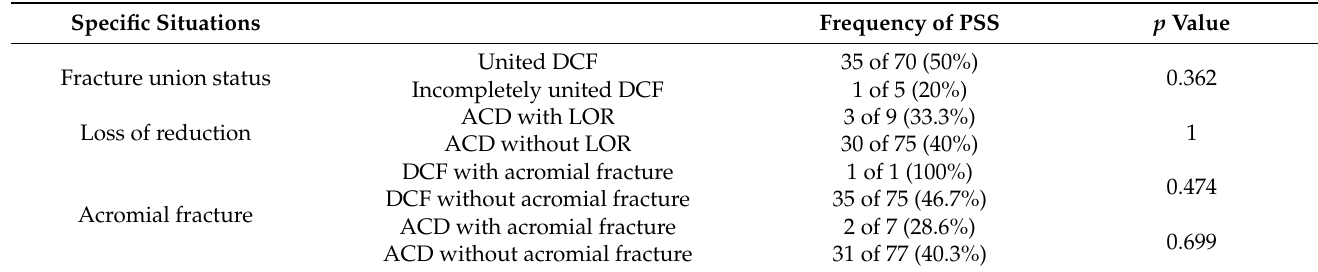
Table 3. Frequency of painful shoulder stiffness in specific situations.